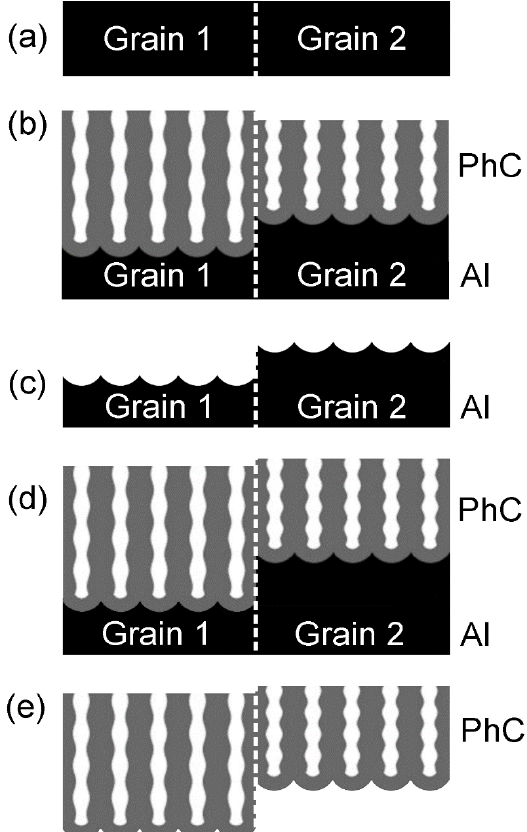
Figure 1. Synthesis of anodic aluminium oxide (AAO) one-dimensional photonic crystal (1D PhC) on coarse-grained Al. ( a ) Mechanically polished Al substrate; ( b ) 1D PhC prepared by Al anodizing; ( c ) Al replica after the selective dissolution of AAO PhC; ( d ) 1D PhC prepared by the second ano- dizing; ( e ) free-standing 1D PhC after the selective dissolution of Al.